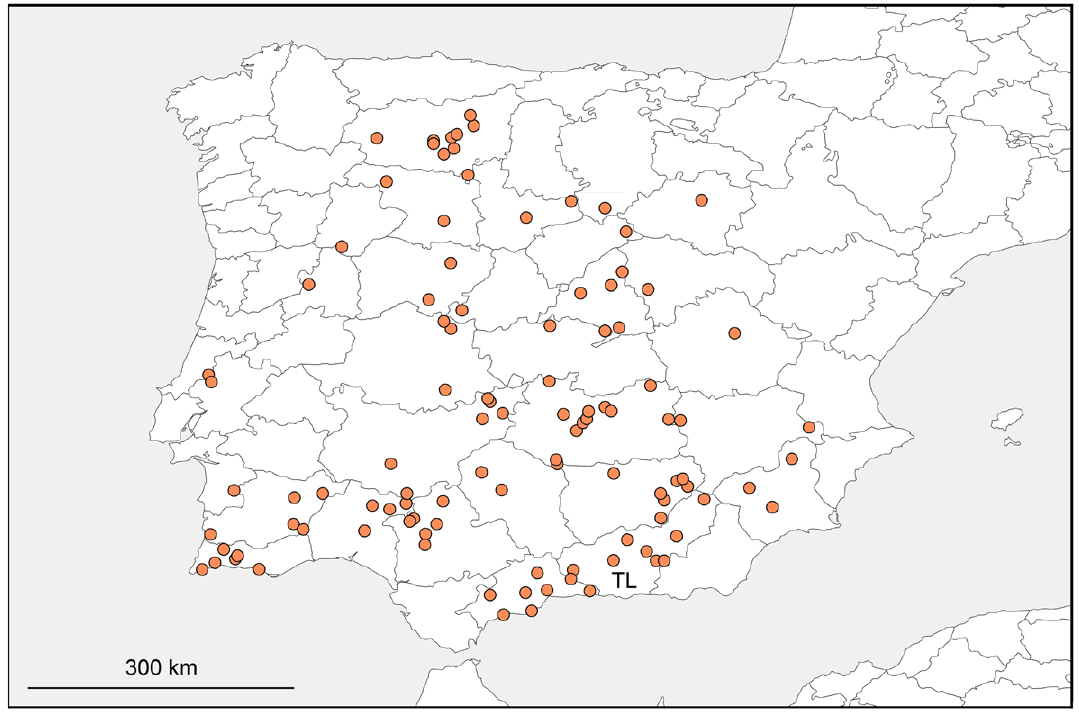
Fig 4. Known distribution of Holocnemus hispanicus Wiehle, 1933 on the Iberian Peninsula. Abbreviation: TL = type